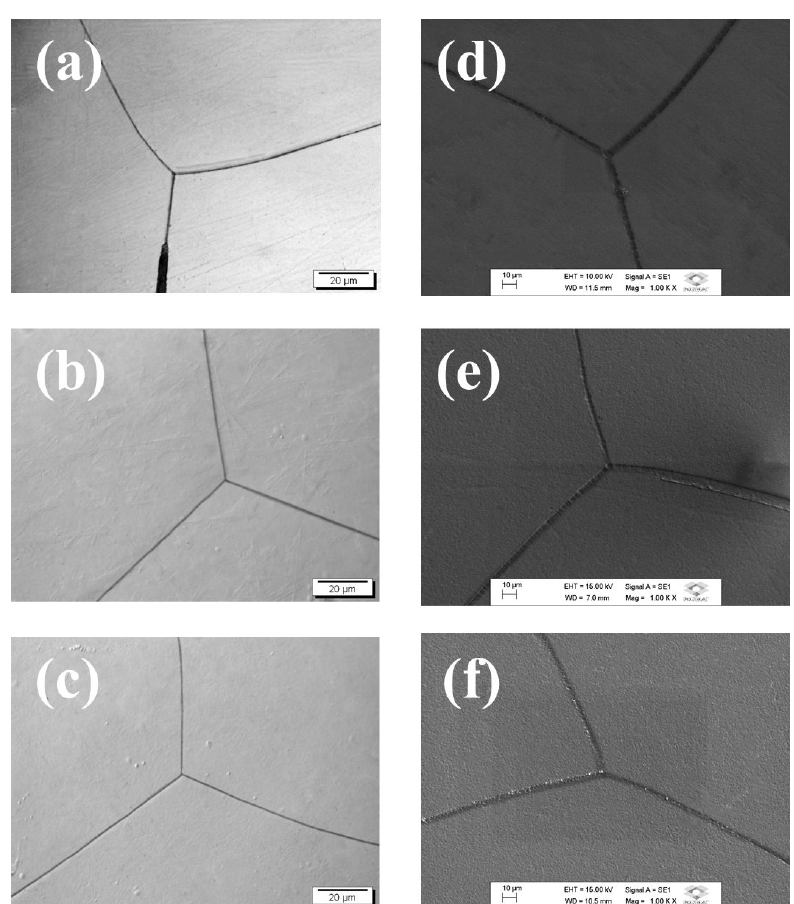
Figure 5. Optical micrographs for Ti-10Mo-30Zr (a), Ti-10Mo-40Zr (b) and Ti-10Mo-50Zr (c) alloys; scanning electron micrographs Ti-10Mo-30Zr (d), Ti-10Mo-40Zr (e) and Ti-10Mo-50Zr (f)